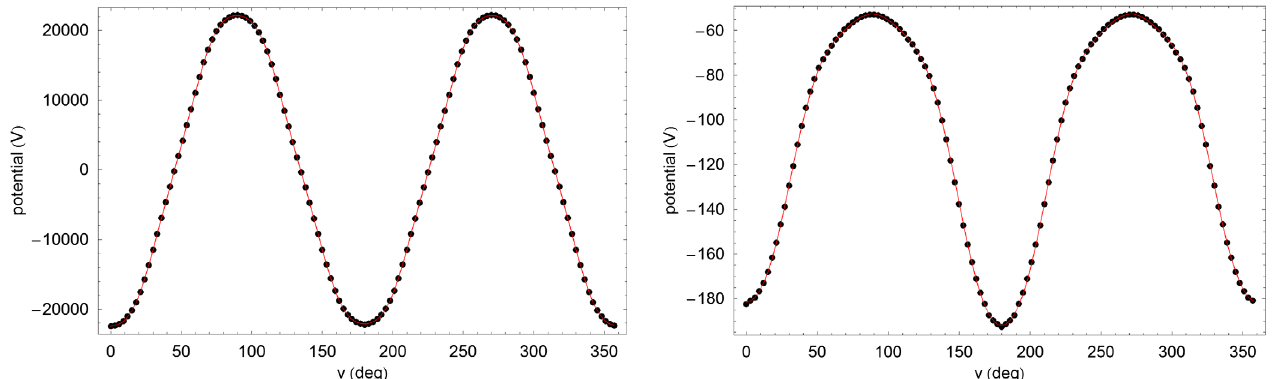
in both cases. The black points show the original data points; the red ref